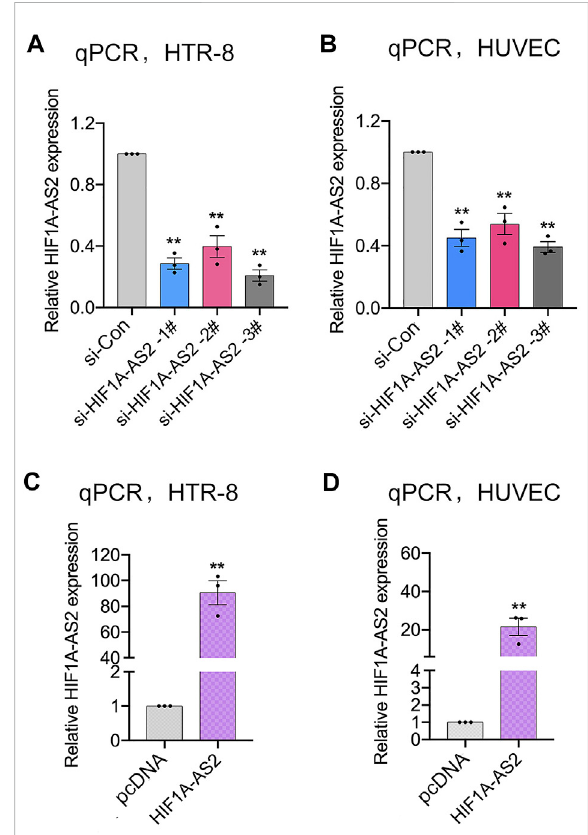
FIGURE 1 Modulation of HIF1A-AS2 expression in trophoblasts. qPCR analysisof HIF1A-AS2 expressioninHTR-8/SVneo (A) andHUVECs (B) after transfected with HIF1A-AS2 – speci fi c siRNAs, respectively. HIF1A-AS2 expression levels were tested by qPCR after treating with empty vector and pcDNA3.1- HIF1A-AS2 plasmid in HTR-8/SVneo (C) and HUVECs (D) . Error bars are mean with SEM of technical replicates ( n = 3).* p < 0.05, ** p < 0.01; signi fi cance by Student ’ s t